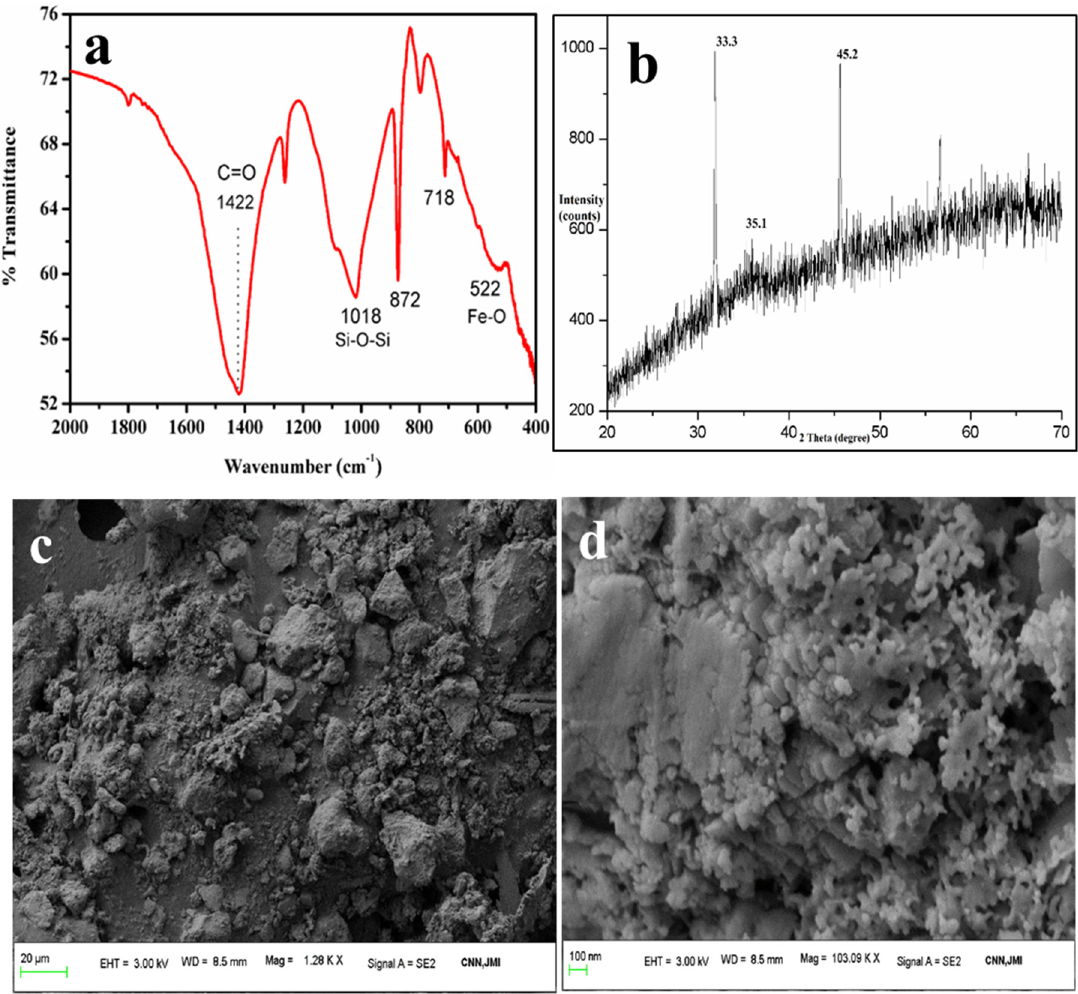
Figure 7. Analysis of iron oxides: ( a ) FTIR, ( b ) XRD, ( c , d ) FESEM micrographs.